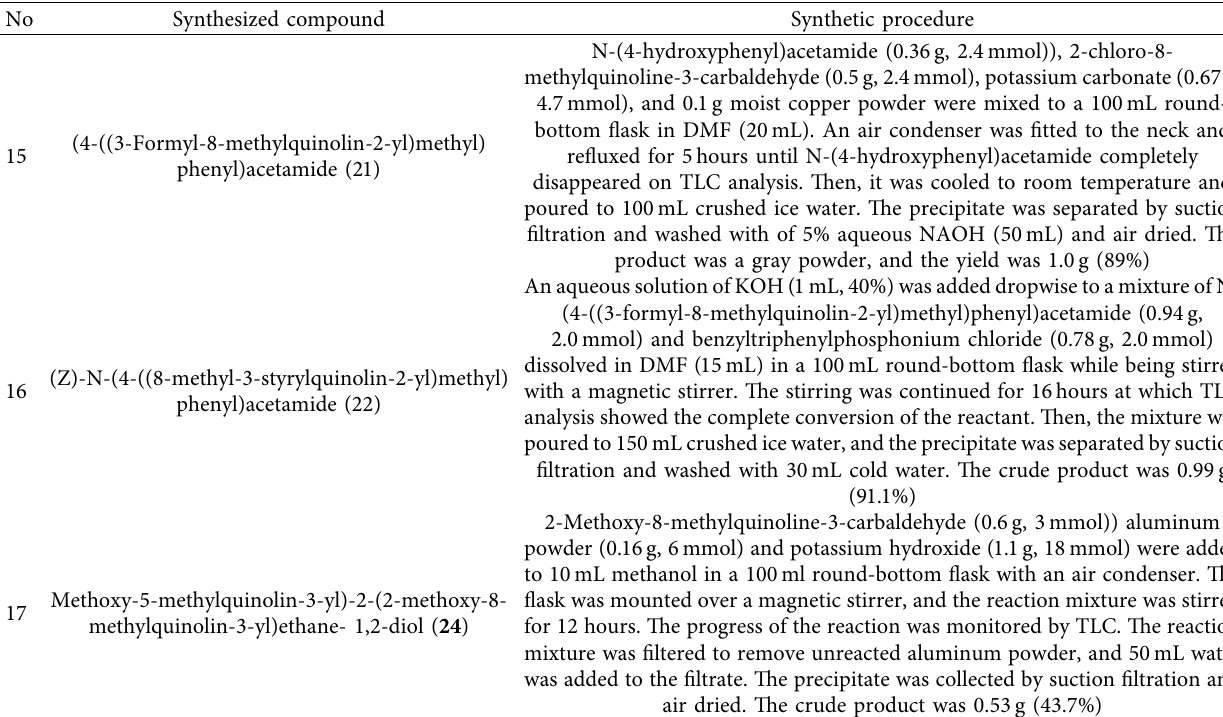
Table 6: Continued table of the synthesized compounds and their synthetic procedure. No Synthesized compound Synthetic